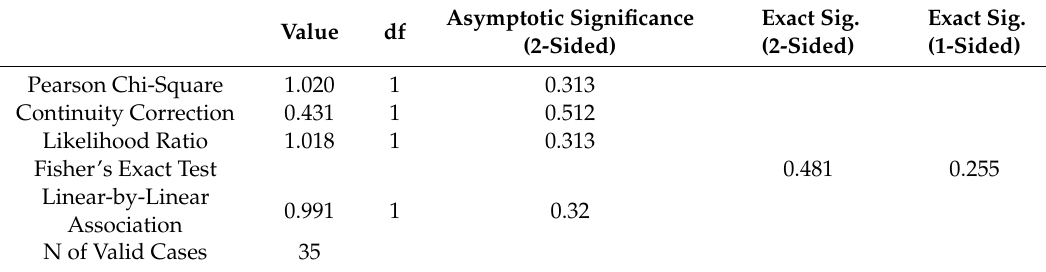
Table 2. The chi-square test for testing time reduction.